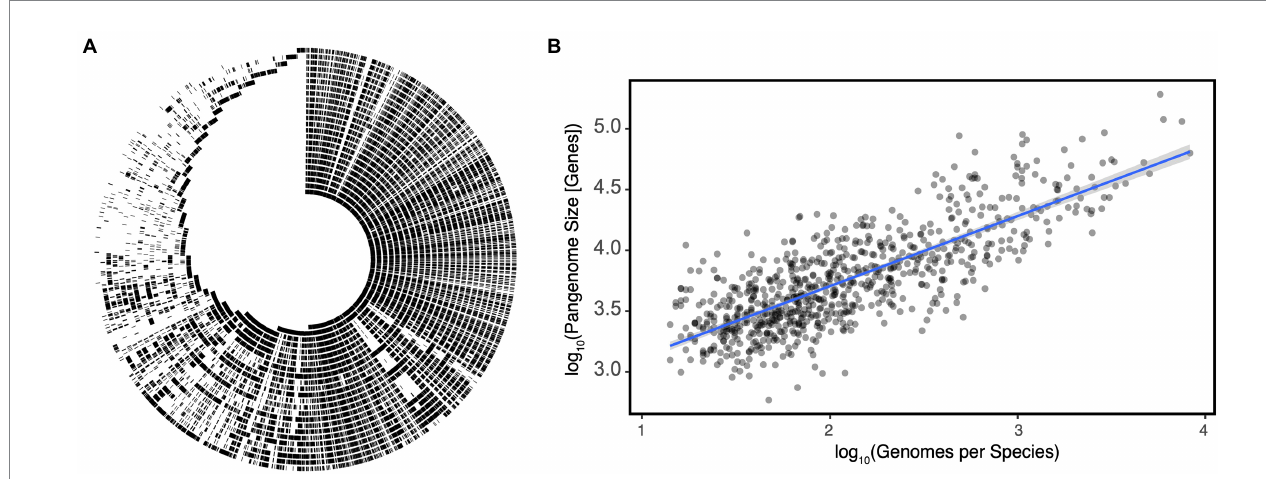
FIGURE 1 (A) An alignment of individual Eggerthella lenta strain genomes demonstrates significant variation in presence/absence of large genetic islands within the species as a function of strain. Each track represents the genome of an individual strain and with shared regions indicated in black. (B) Pangenome size increases linearly with the number of genomes sequenced per species in gut microbes. Each point represents a species with the blue line representing a linear regression ±SE. Data for (A,B) reproduced from Bisanz et al. (2020) and Almeida et al. (2021),